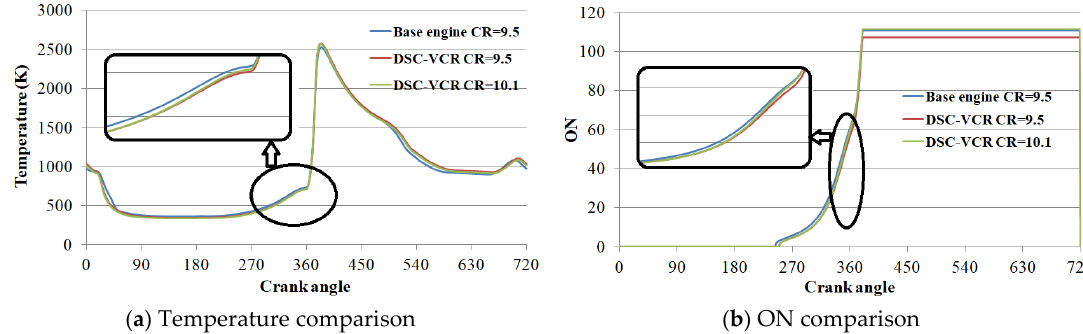
Figure 16. Comparison of the in-cylinder temperature and ON for different engines in case 1.